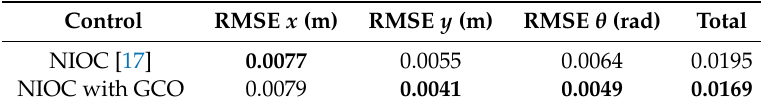
Table 3. Root Mean Squared Error (RMSE) in states for first simulation. Bold values highlight the best result.